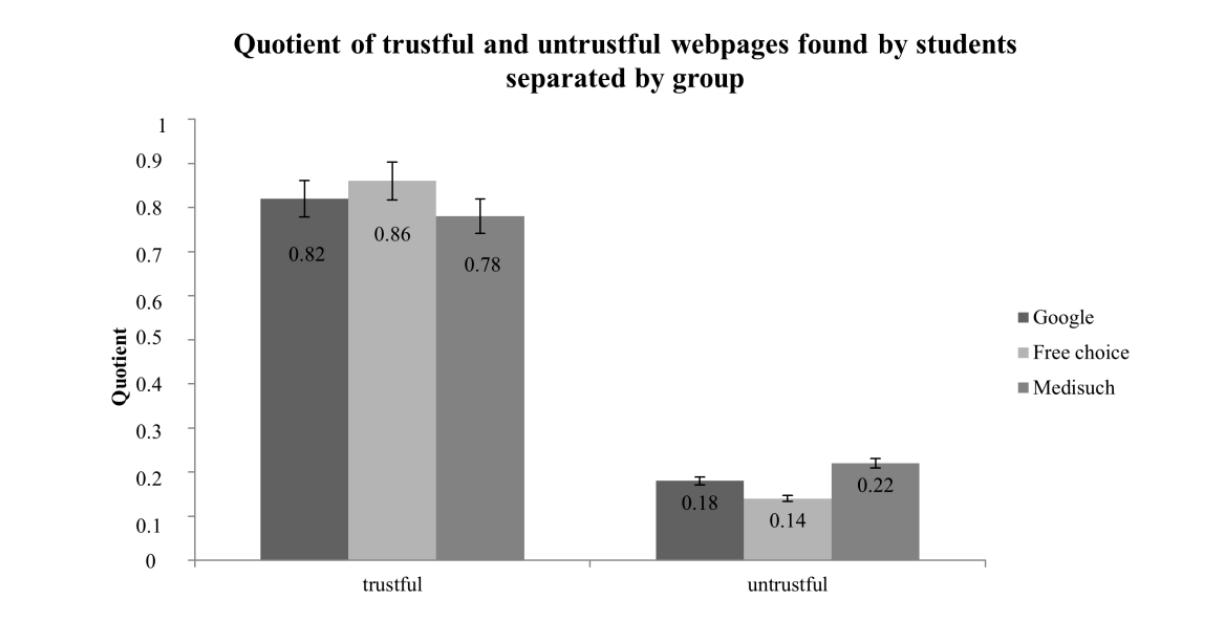
Figure 4. Quotient of trustworthy or untrustworthy webpages found by students separated by